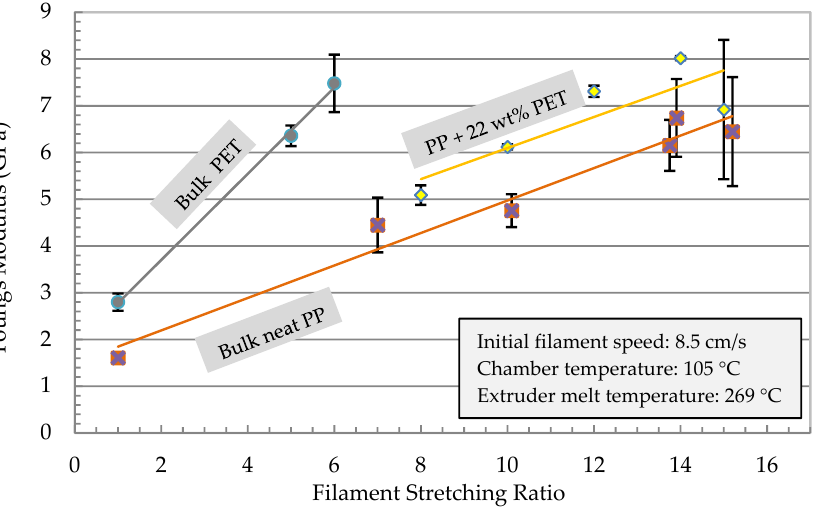
Figure 13. Young's modulus of stretched neat PP, PET and PP/22 wt% PET filaments. Figure 13. Young’s modulus of stretched neat PP, PET and PP/22 wt% PET